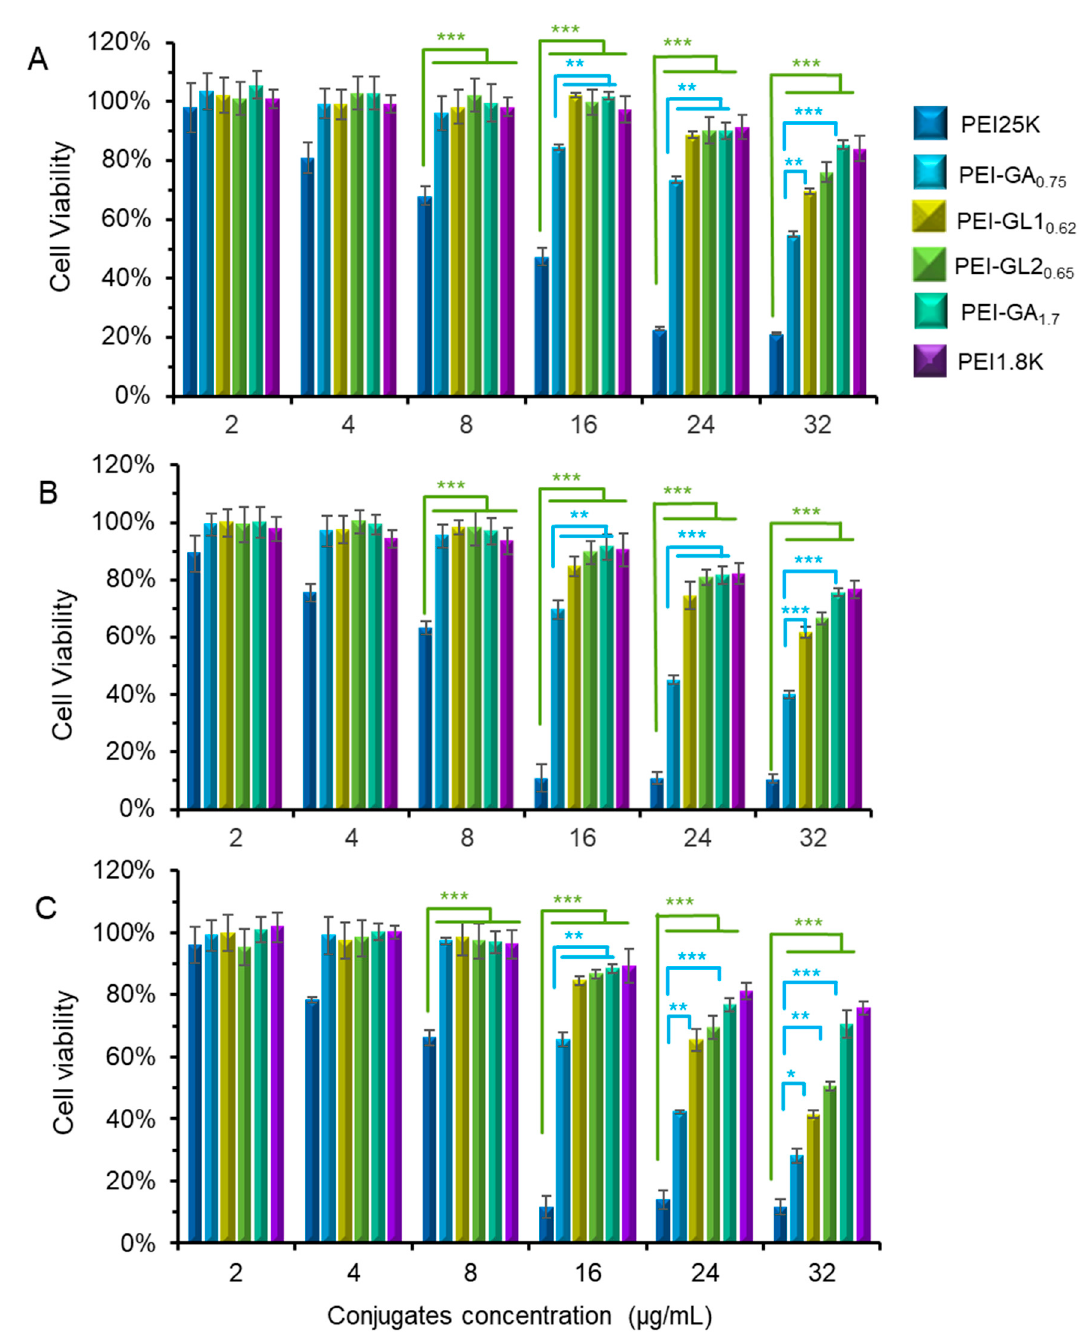
Figure 4. Cell viability of the PEI-GA and PEI-GL conjugates at concentrations ranging from 2 to 32 μ g/mL after 48h incubation, using PEI1.8K and PEI25K as controls. *** p value < 0.001. ** p value < 0.01 using t -test (unpaired). Results are shown as mean ± SD ( n = 3). ( A ) HepG2 cells, ( B ) SW480 cells, and ( C ) A549 cells.